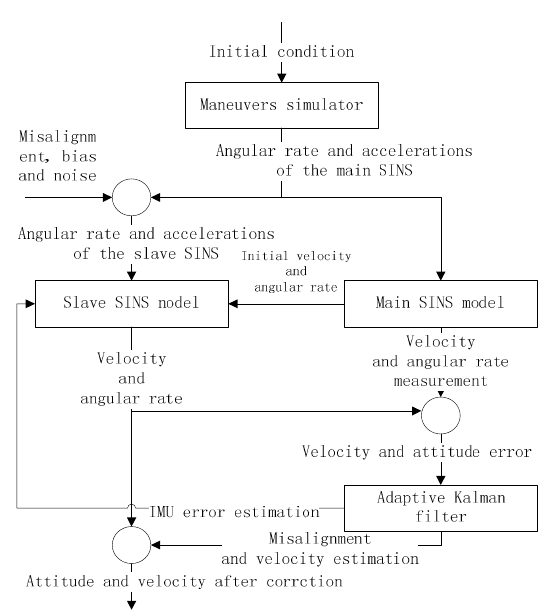
Figure 3. Schematic diagram of the transfer alignment algorithm.